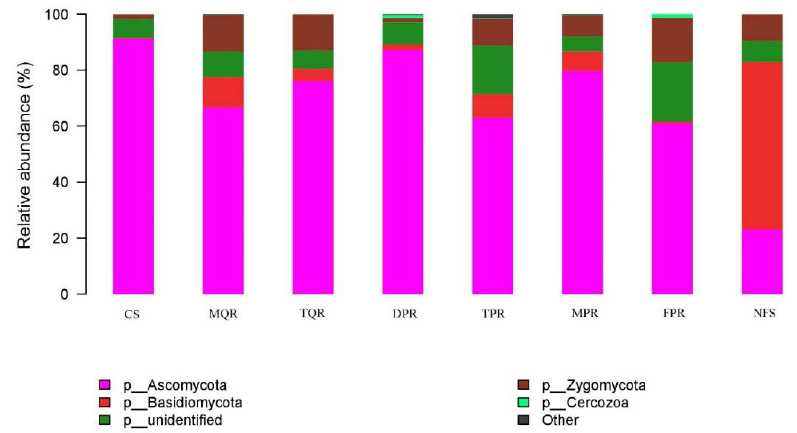
Figure 2. Distribution of ITS sequences across fungal communities. CS, control soil; MPR, middle portion of Pinus tabuliformis roots; TPR, tips of P. tabuliformis roots; MQR, middle portion of Quercus variabilis roots; tips of Q. variabilis roots; FPR, post-fire planted forest of P. tabuliformis ; DPR, dead P. tabuliformis roots; NFS, natural P. tabuliformis forest.